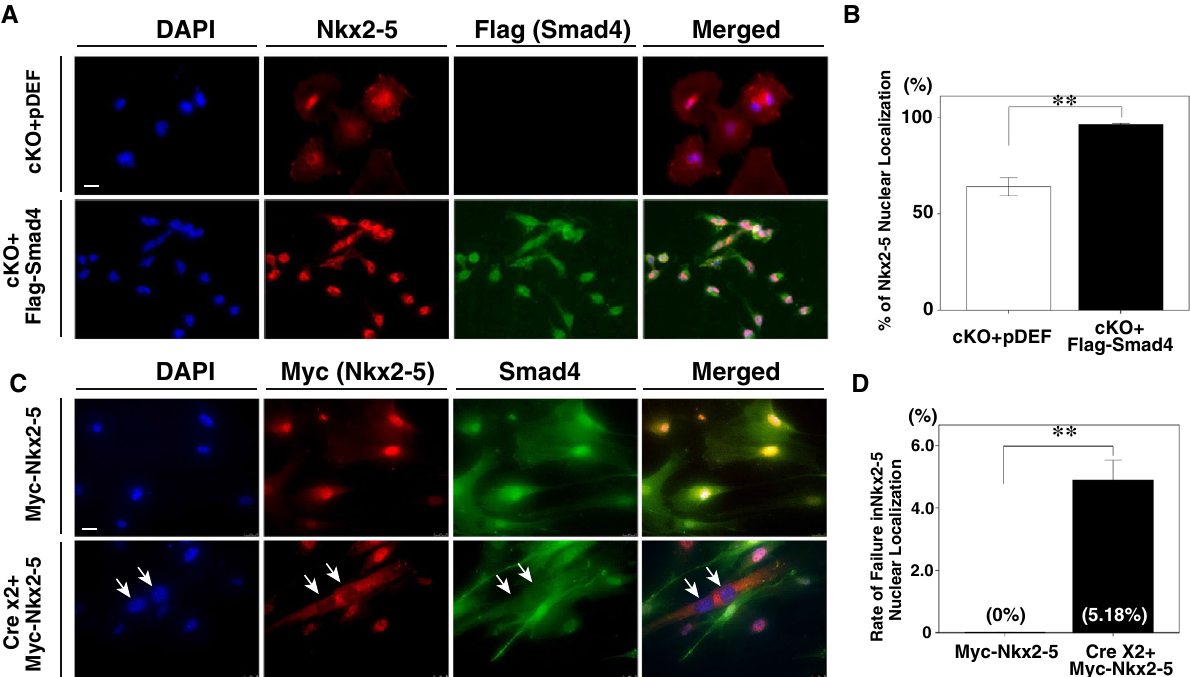
Figure 4. Introduction of Smad4 rescues the nuclear localization of Nkx2-5 in mutant cells and depletion of the Smad4 gene blocks the nuclear translocation of Nkx2-5 in fibroblast cells. ( A ) Double immunohistochemistry with anti-Nkx2-5 (red) and anti-Flag (green) antibodies. Cells from Smad4 -cKO embryonic hearts were transfected with an empty vector (pDEF) as a control (upper panels) or Flag-tagged Smad4 expression vector (lower panels). Arrows show the failure of Nkx2-5 to localize to the nucleus. DAPI was used to stain nuclei. ( B ) Percentage of cells showing nuclear localization of Nkx2-5. Nuclear localization of Nkx2-5 was significantly increased in the presence of Smad4, compared to cells transfected with empty vector. Data were collected from 20 slides for each experiment (n = 4 and 4 for control and Smad4 -cKO, respectively). Data are presented as mean ± SEM. * P < 0.01 (Mann–Whitney U test). ( C ) Double immunohistochemistry with anti-Myc (red) and anti-Smad4 (green) antibodies. Fibroblast cells from Smad4f. /f embryos were transfected with the Myc-Nkx2-5 expression vector and showed nuclear localization of Nkx2-5. After depleting Smad4 by transfecting fibroblasts with Cre expression vector twice, Nkx2-5 was no longer localized to the nucleus. DAPI was used to stain nuclei. ( D ) The proportion of non-nuclear localization of Nkx2-5 in control (transfected with Myc-Nkx2-5) and Smad4 -cKO (transfected with Myc-Nkx2-5 after two rounds of Cre expression vector transfection) cells. Data were collected from 20 slides for each experiment (n = 3 and 3 for control and Smad4 -cKO, respectively). Data are presented as mean ± SEM. ** P < 0.01 (Mann–Whitney U